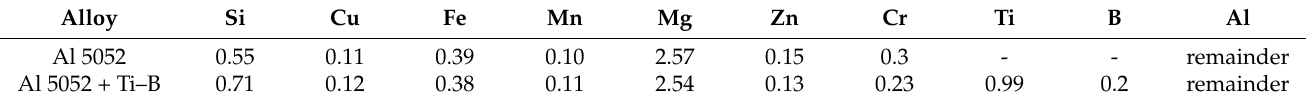
Table 1. The chemical composition of the standard Al 5052 alloy and that modified with Ti–B (wt.%).